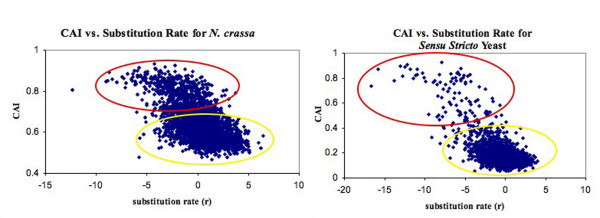
Graphs of Codon Adaptation Index (CAI) vs. normalized substitution rates. Data for the sensu stricto yeasts (S. cerevisiae, S. bayanus, S. mikatae, S. paradoxus) (right) and for N. crassa-C. globosum (left) are both shown. Although the r distribution for N. crassa-C. globosum (Fig 1c) is wider than a Normal distribution, this appears to be due to a large number of genes under codon usage selection, rather than regional mutational biases. Genes under codon usage bias tend to have low z-scores and high CAI values (red ellipse), while the remaining genes have low CAI values and r values centered around zero (yellow ellipse). N. crassa has a much larger number of genes in the cluster likely to be under codon usage selection (949 genes with CAI≥0.70, red ellipse) than does S. cerevisiae (121 genes with CAI≥0.40), suggesting that more genes are under codon usage selection in N. crassa.